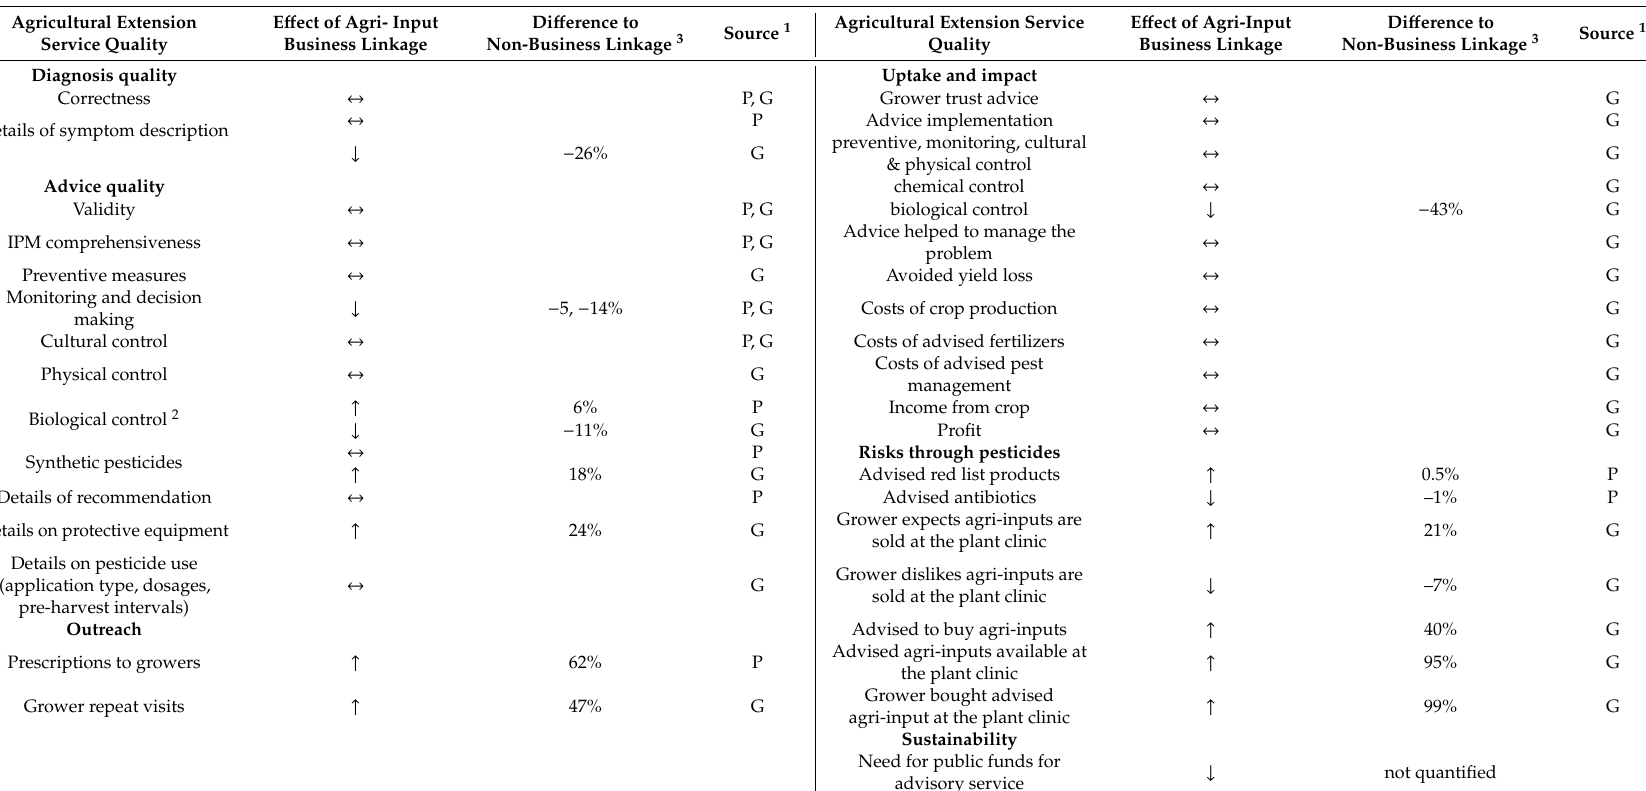
Table 3. Advantages and disadvantages of agri-input-business linkage in agricultural extension services in Beijing municipality,